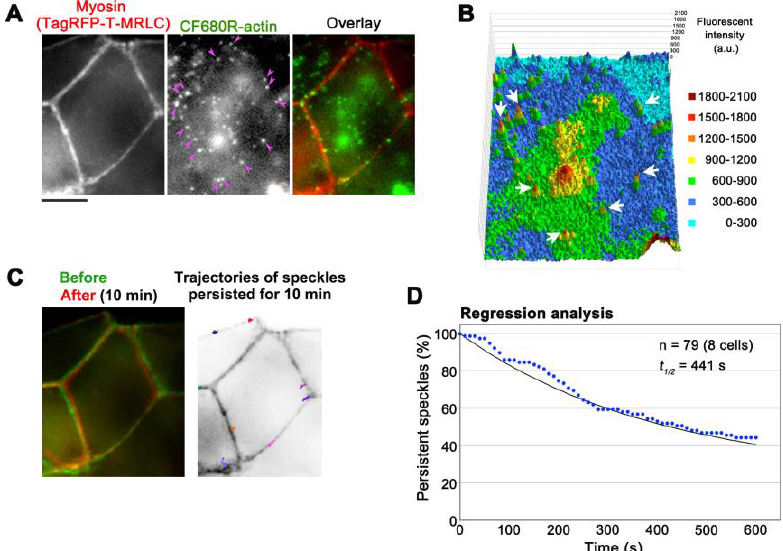
Figure 5. Observation of CF680R-actin SiMS in actomyosin bundles associated with adherens junctions (AJs) in A6 cells. ( A ) Representative images of actomyosin bundles visualized by TagRFP-T-myosin regulatory light chain (MRLC, left), CF680R-actin SiMS (middle), and the merged image (right). Pink arrowheads indicate CF680R-actin SiMS in actomyosin bundles associated with AJs. Bar = 5 µm; ( B ) The middle image of ( A ) is shown in a 3D profile, in which the z -axis represents the fluorescence intensity of CF680R-actin. The fluorescence intensity of each pixel is shown with colors as indicated. White arrows indicate CF680R-actin SiMS; ( C ) Left: A merged image of actomyosin bundles associated with AJs visualized by TagRFP-T-MRLC before (green) and after (red) a 10 min time-lapse imaging of CF680R-SiMS. Right: Trajectories of CF680R-actin SiMS in actomyosin bundles associated with AJs. The trajectories of actin SiMS that persisted from the first image to the last image of a 10 min time-lapse imaging were indicated with colored lines and overlaid with the inverted image TagRFP-T-MRLC (before); ( D ) Speckle regression analysis of CF680R-actin SiMS in actomyosin bundles associated with AJs in eight cells. The black line indicates that the one-phase exponential curve fitted to the data (blue dots) gives 441 s for the half-life of SiMS.